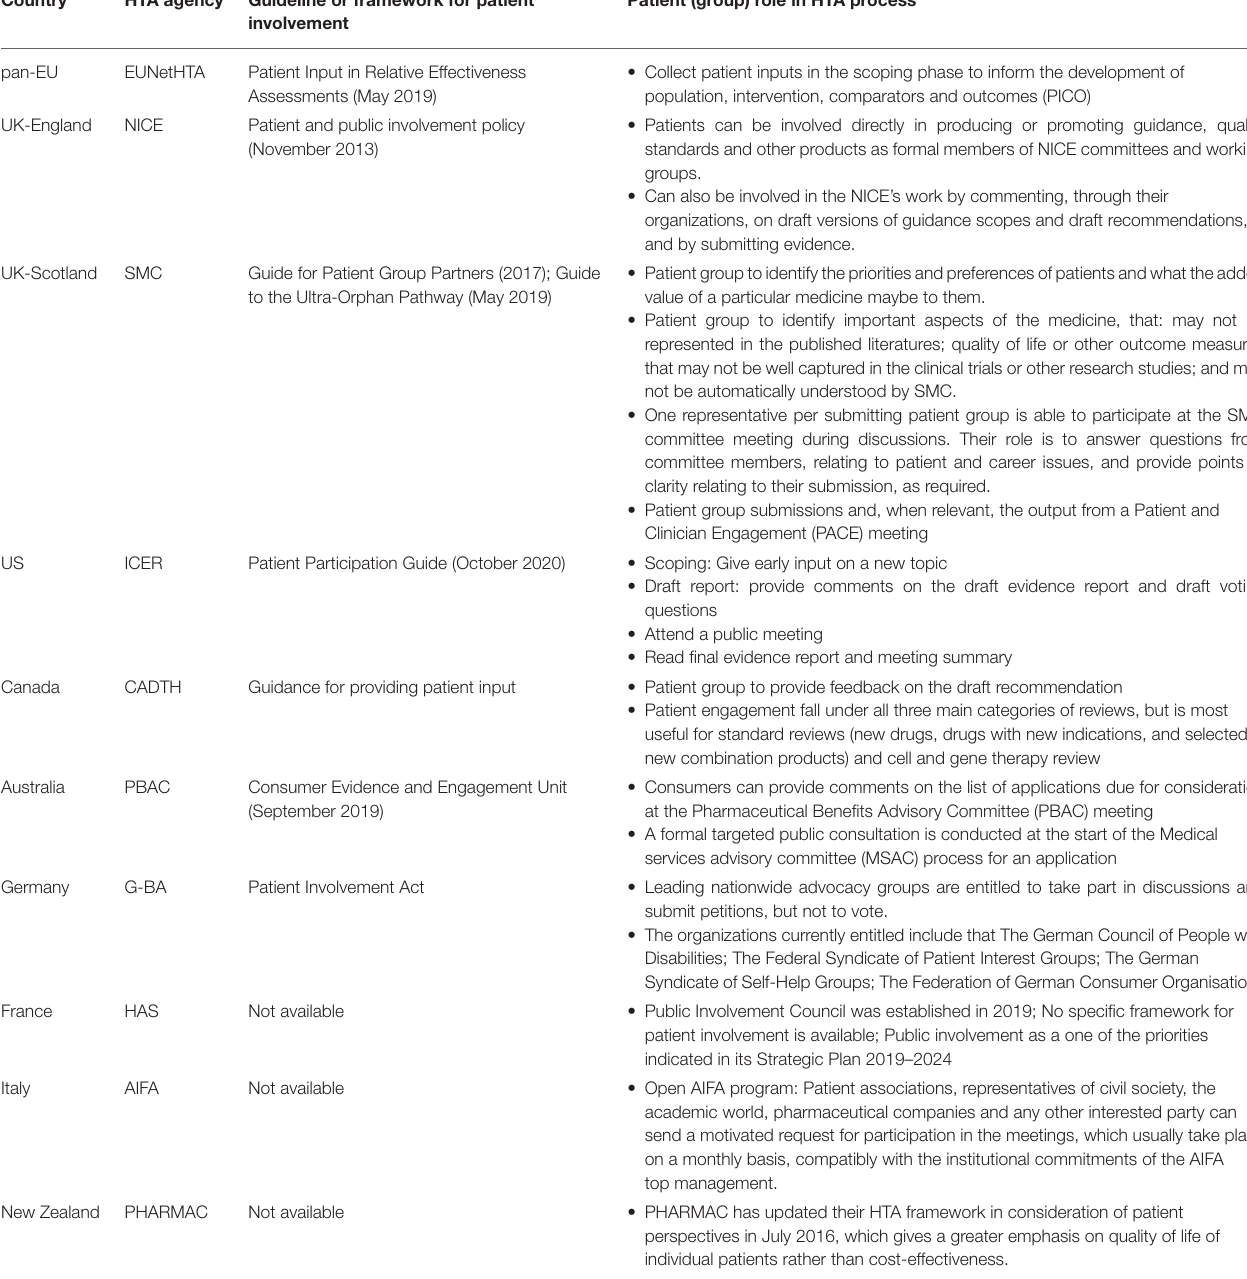
TABLE 3 | Patient involvement in the HTA process.